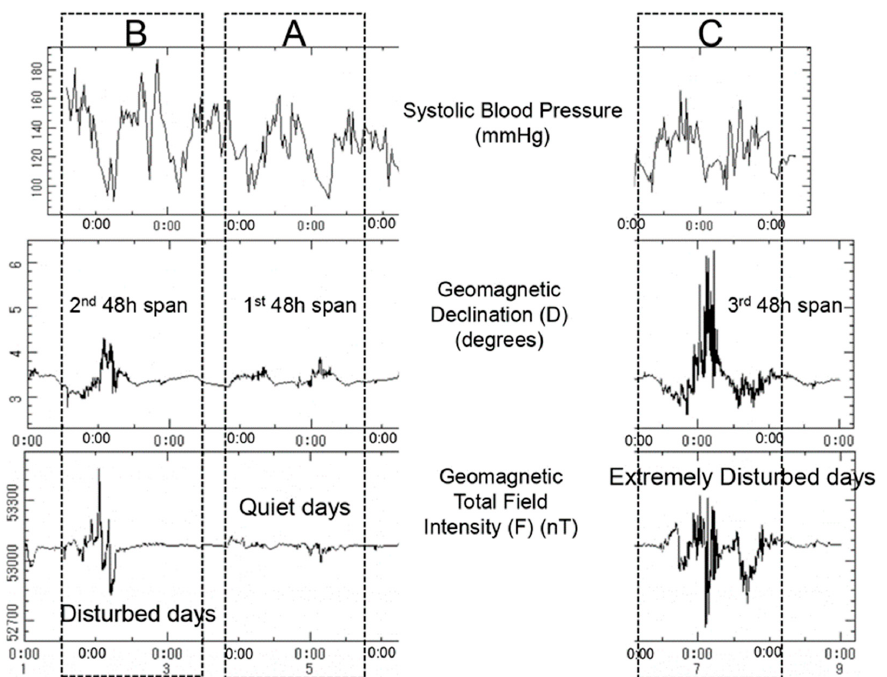
Figure 3. Illustration of SBP, geomagnetic declination, D (°), and total intensity, F (nT), in one participant. ( A ): 48 h span during quiet conditions; ( B ): 48 h span during moderate geomagnetically disturbed conditions; ( C ): 48 h span during extreme geomagnetically disturbed conditions. The circadian amplitude of SBP is apparently increased during moderate geomagnetic disturbances ( B ) compared to geomagnetic quiet conditions ( A ), but it may be suppressed during extreme geomagnetic disturbances ( C ). Table 3. Response of blood pressure and heart rate to moderate and extreme magnetic activity in 2 participants undergoing 7-day/24 h ABPM.